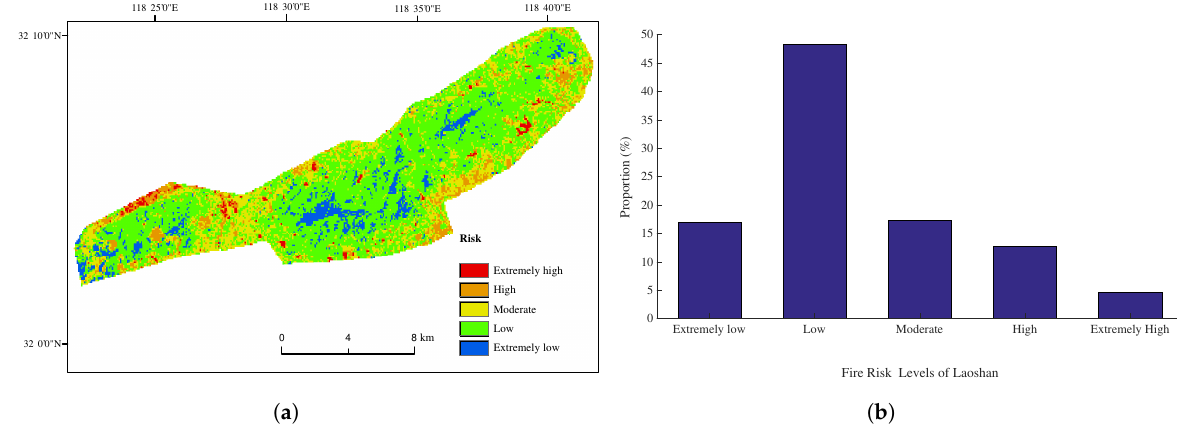
Figure 14. The forest fire risk map and proportion of each level of the risk area. ( a ) The generated forest fire risk map. ( b ) The proportion of areas of each fire risk level. The percentage represents the ratio of the area of each risk level to the area of Laoshan Forest